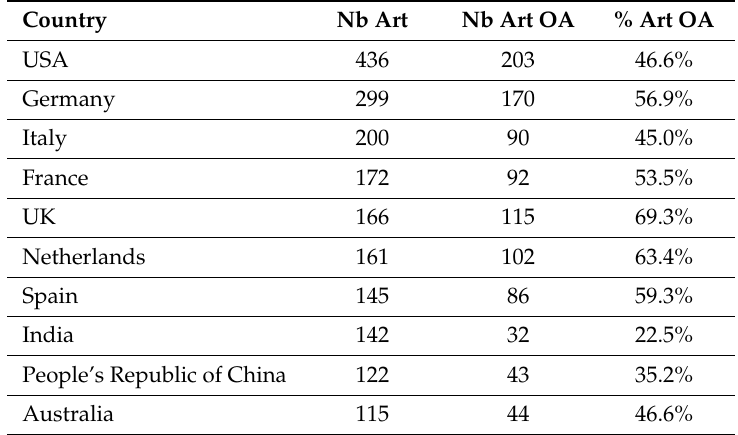
Table 11. Ten countries with articles and OA articles ( n = 2489).